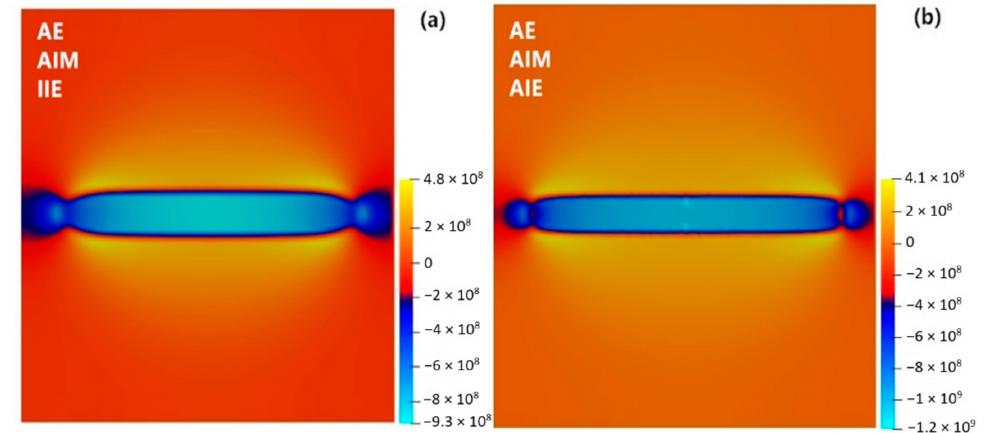
Figure 7. Stress ( σ xx ) distribution around the θ (cid:48) precipitate with ( a ) AE, AIM and IIE conditions and ( b ) AE, AIM and AIE conditions in Al-1.69 at.% Cu alloy annealed at 453 K for t = 100,000